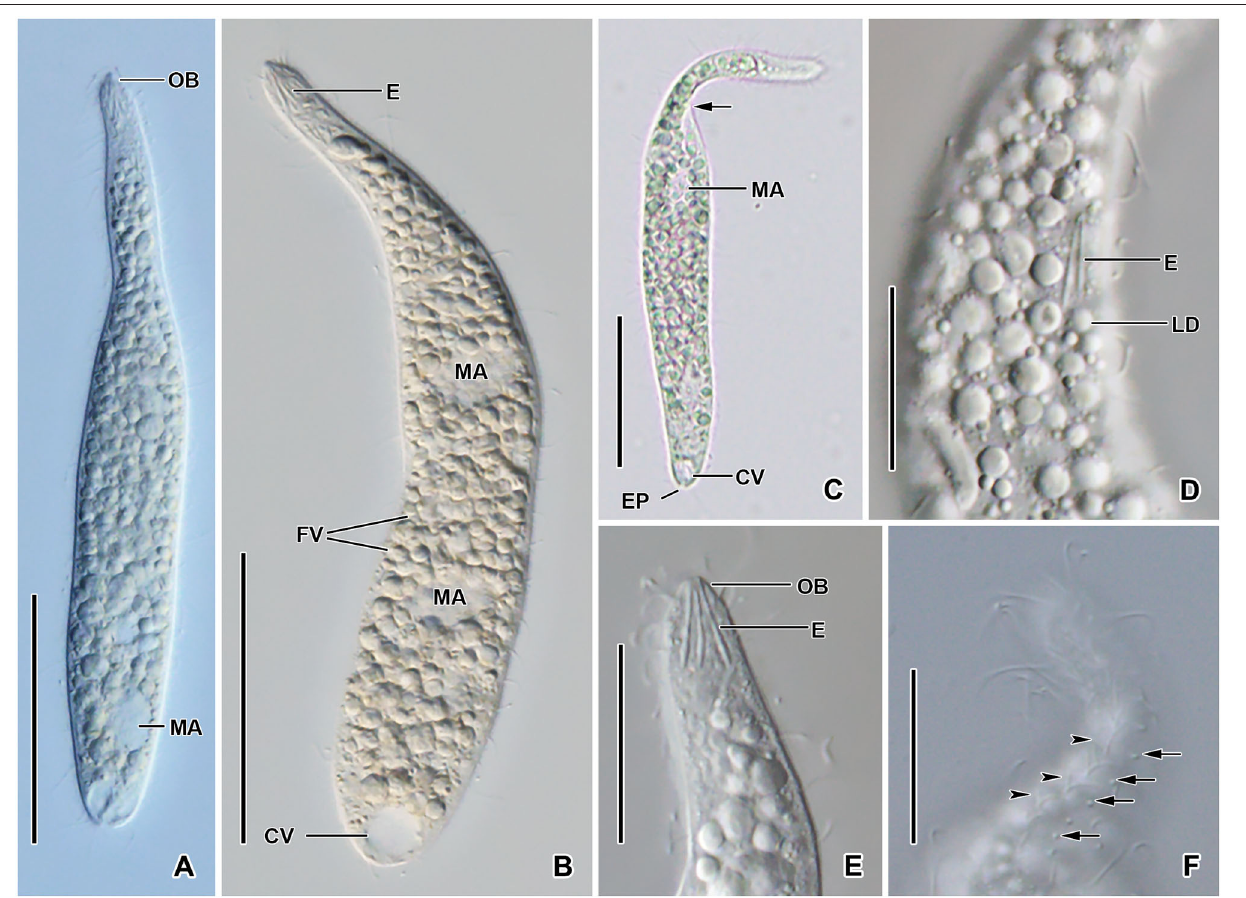
FIGURE 2 | Monolamellophrya terricola gen. nov., sp. nov. from life. (A–C) Overviews showing the body shape, the narrow neck, the terminal contractile vacuole, the nuclear apparatus, and the cytoplasm studded with food vacuoles and lipid droplets. The arrow shows that the body is laterally flattened. (D,E) Optical sections showing the acicular extrusomes in cytoplasm (D) and oral bulge (E) and the lipid droplets. (F) The dorsal brush, showing the curved, V-like spread bristles of brush row 2 (arrowheads) and the acicular bristles of brush row 3 (arrows). B1–3, dorsal brush rows; CK, circumoral kinety; CV, contractile vacuole; E, extrusomes;